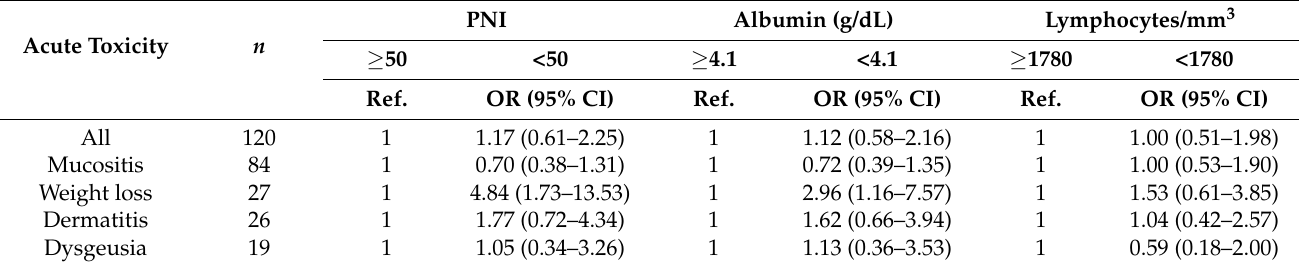
Table 2. Odds ratio (OR) and 95% confidence interval (CI) 1 for acute G3–G4 toxicity according to nutritional